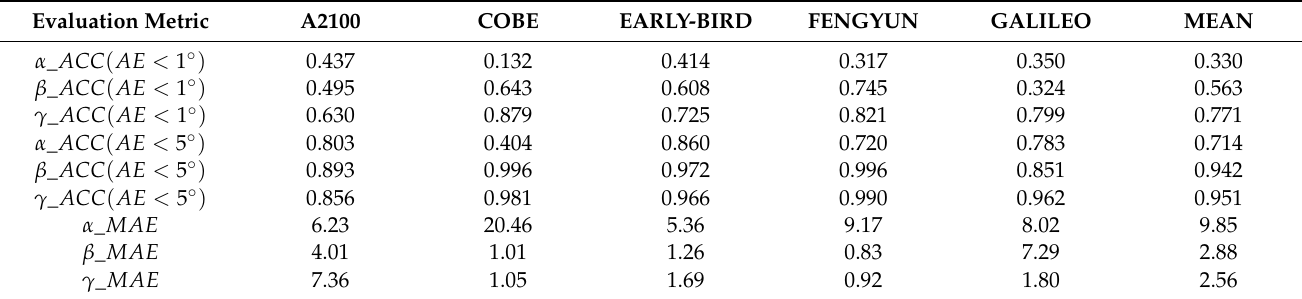
Table 8. Performance on the BUAA-SID-POSE 1.0 dataset.